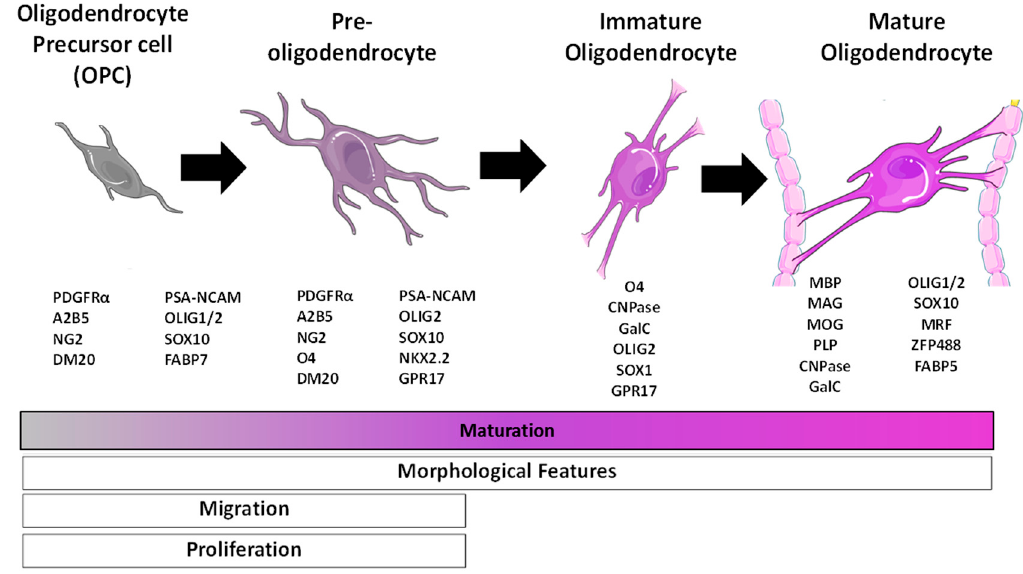
Figure 3. Specific proteins and transcription factors are expressed at the different stages of oligodendrocyte (OL) differentiation. These stages are recognised by the expression of well-characterised markers, distinct morphology, and their ability to proliferate, migrate, and differentiate. Modified from [79].